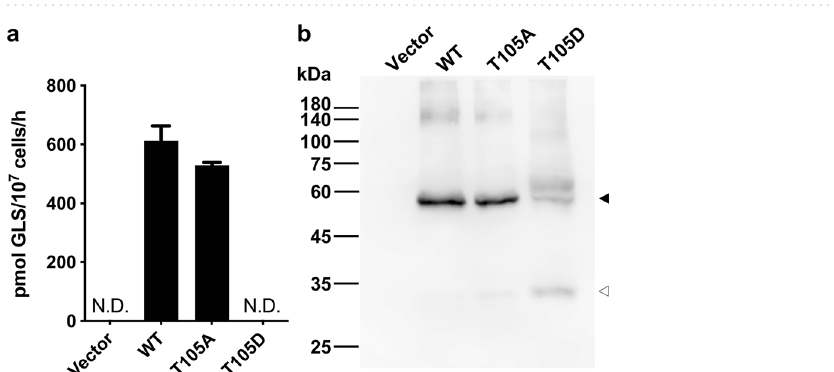
Figure 6. Purified AtGTR1 primarily adopts a homodimeric conformation. ( a ) SEC chromatogram of AtGTR1 showed that the major eluted peak corresponded to molecular size near 158 kDa. Points indicate the retention volume of each standard protein marker with labeled molecular sizes (kDa). ( b,c ) The AtGTR1 purified by IMAC and SEC were respectively analyzed by ( b ) SDS-PAGE and ( c ) western blot with anti-His tag antibody. The filled triangle indicates the AtGTR1 monomer, whereas the open triangle indicates the predicted dimer.